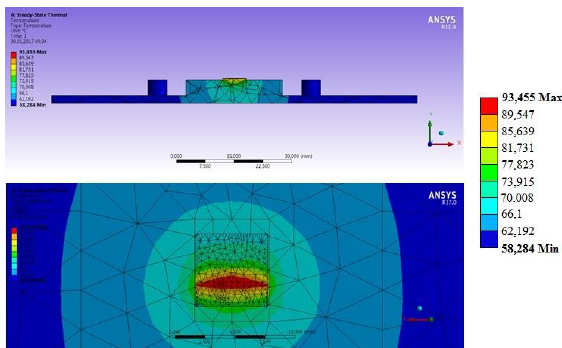
Figure 8: Thermal simulation results at 25 °C ambient. Top picture front view and bottom picture top